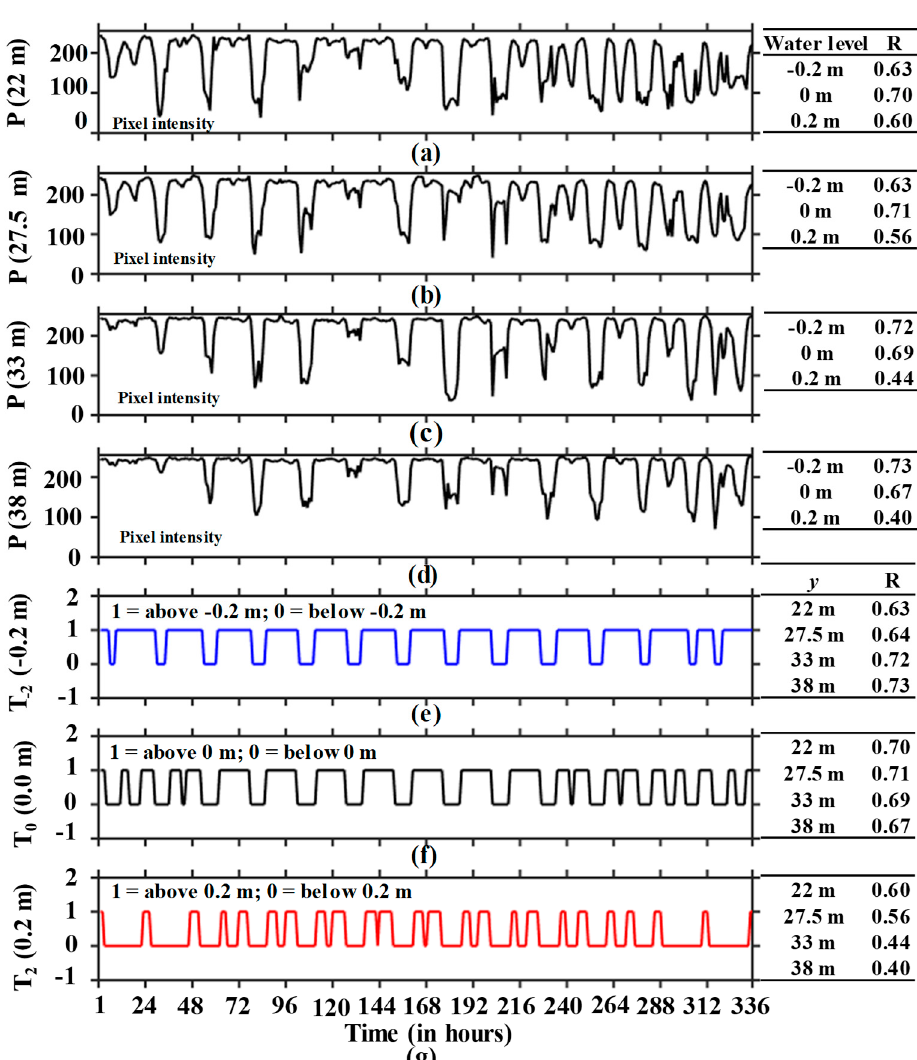
Figure 7. The pixel intensities over two weeks (17–30 June 2005) at x = − 49 m and ( a ) y = 22 m, ( b ) y = 27.5 m, ( c ) y = 33 m, and ( d ) y = 38 m. ( e ) The tidal binary signal indicating above or below water level − 0.2 m: ( f ) water level 0.0 m and ( g ) water level 0.2 m. The tables on the right-hand side of a–g illustrate the correlation coefficients between the pixel intensity variation and tidal binary signals. Higher correlation values show strong similarities between pixel intensity variation and binary signal representation of tide records.